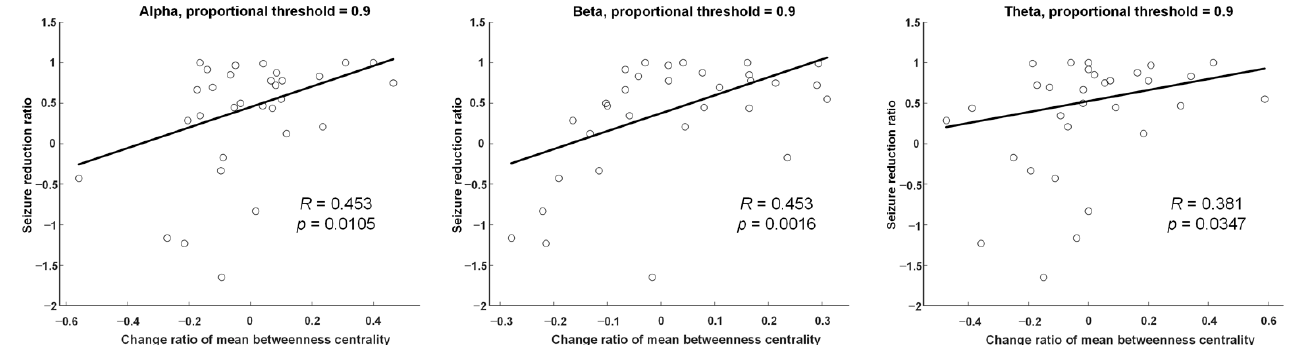
Figure 6. Linear regression analysis was used to explore the relationship between alteration of mean betweenness centrality of weighted adjacency matrices with densities of 90% and seizure reduction rate in alpha ( R = 0.453, p = 0.0105), beta ( R = 0.453, p = 0.0016), and theta ( R = 0.381, p = 0.0347) frequency bands.